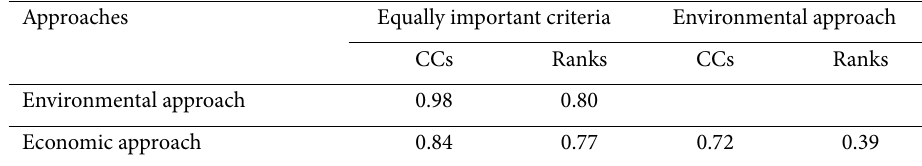
Table 5. Correlation between closeness coefficients (CCs) and ranks across different approaches